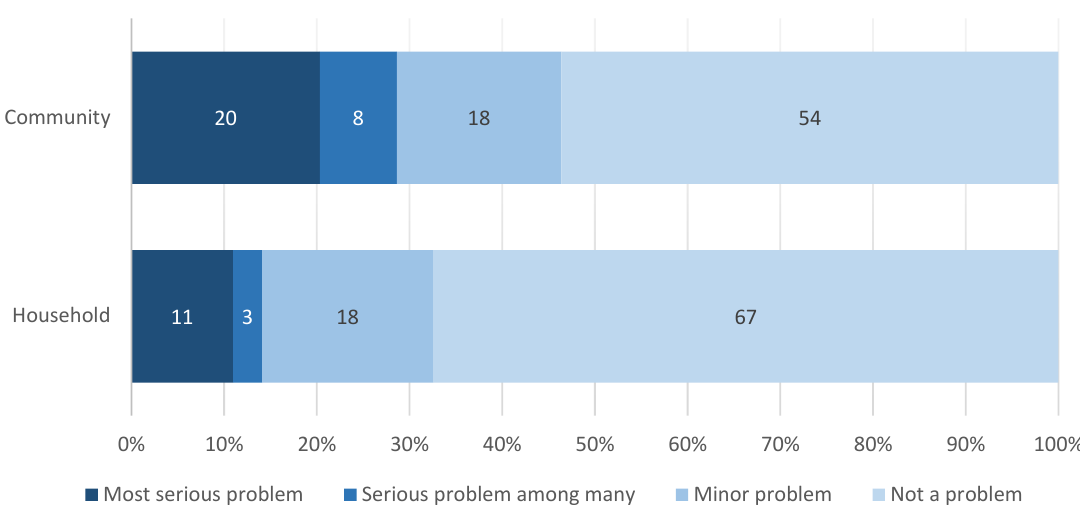
Fig. A1.2. Share of population who reported flooding to be a serious problem based